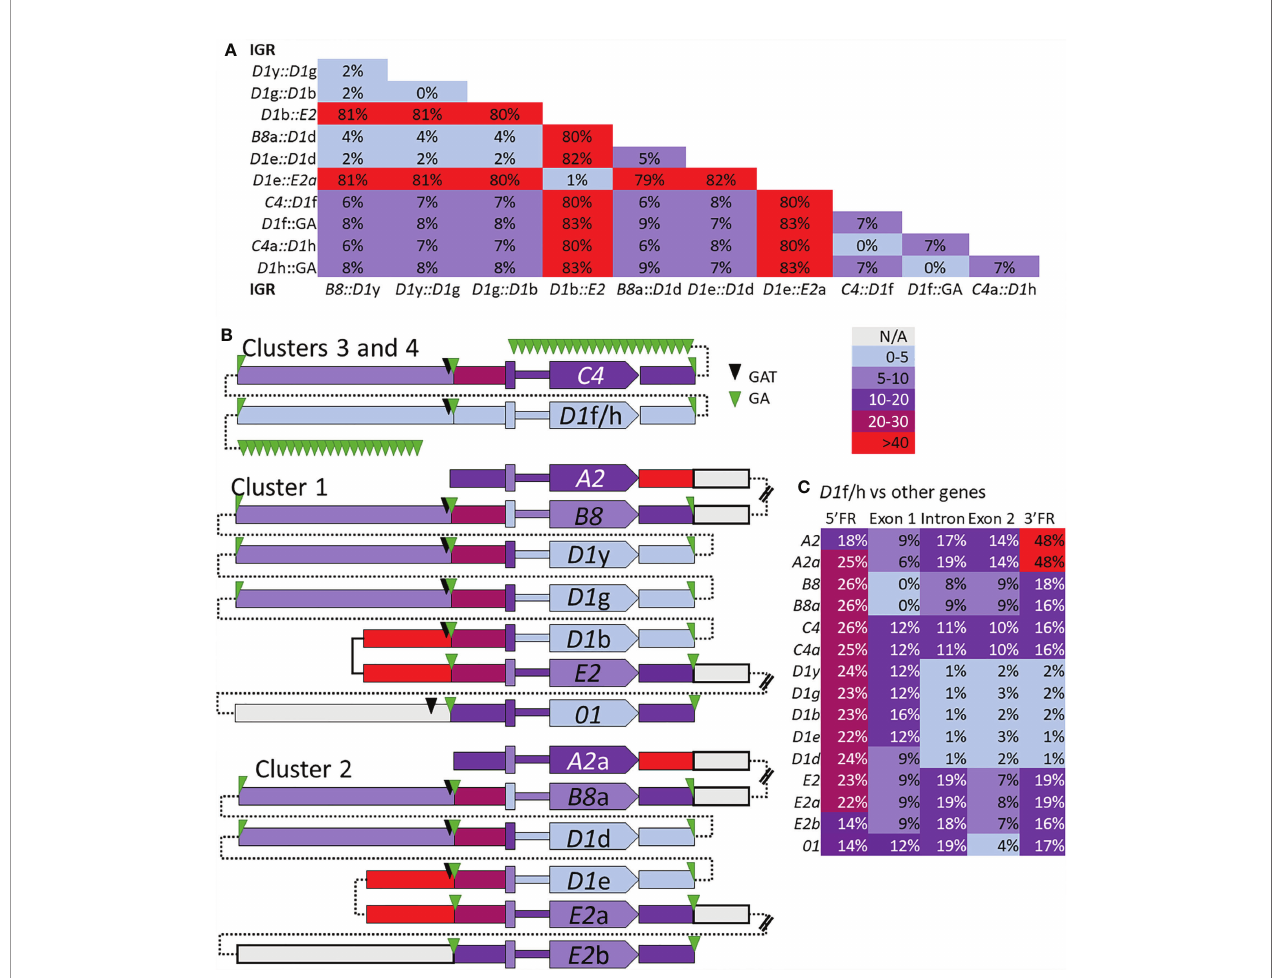
FIGURE 7 | The percent mismatch between regions of the SpTrf genes suggests that the segmental duplications include the B8 and C4 genes with the D1 genes. Alignments of the B8 /a:: D1 y/d-IGRs, the D1 IGRs, the D1 b/e:: E2 /a-IGRs, and the C4 /a:: D1 h/f-IGRs, plus the alignment of the 5 ʹ FR, exon 1, the intron, exon 2, and the 3 ʹ FR for all SpTrf genes were done with PRANK. (A) The pair-wise percent mismatch scores for IGRs indicate the level of sequence similarity. Percent mismatches were calculated from pairwise diversity scores in MEGA7 and are indicated with the color gradient legend. There are no mismatch scores between 30-40%. (B) A graphical representation shows levels of sequence similarities among genes and IGRs based on percent mismatch scores against the D1 f/h genes. All genes are oriented in the same direction as indicated by the pointed polygon labeled with the gene name. From left to right across the fi gure are blocks that represent the IGRs, GA and/ or GAT STRs, the 5 ʹ FR, the exon 1, the intron (narrow region), the exon 2 with the gene name, and the 3 ʹ FR. The thin dotted lines indicate how the sequences are linked together in their respective clusters and do not indicate sequence. The double bars in some IGRs indicate sequence that was not analyzed and is not shown. Percent mismatches for all blocks are color coded based on the gradient key. (C) The percent mismatch values for the regions of all SpTrf genes compared to the D1 f/h indicates regions of similarity and dissimilarity. Results are color coded according to the gradient